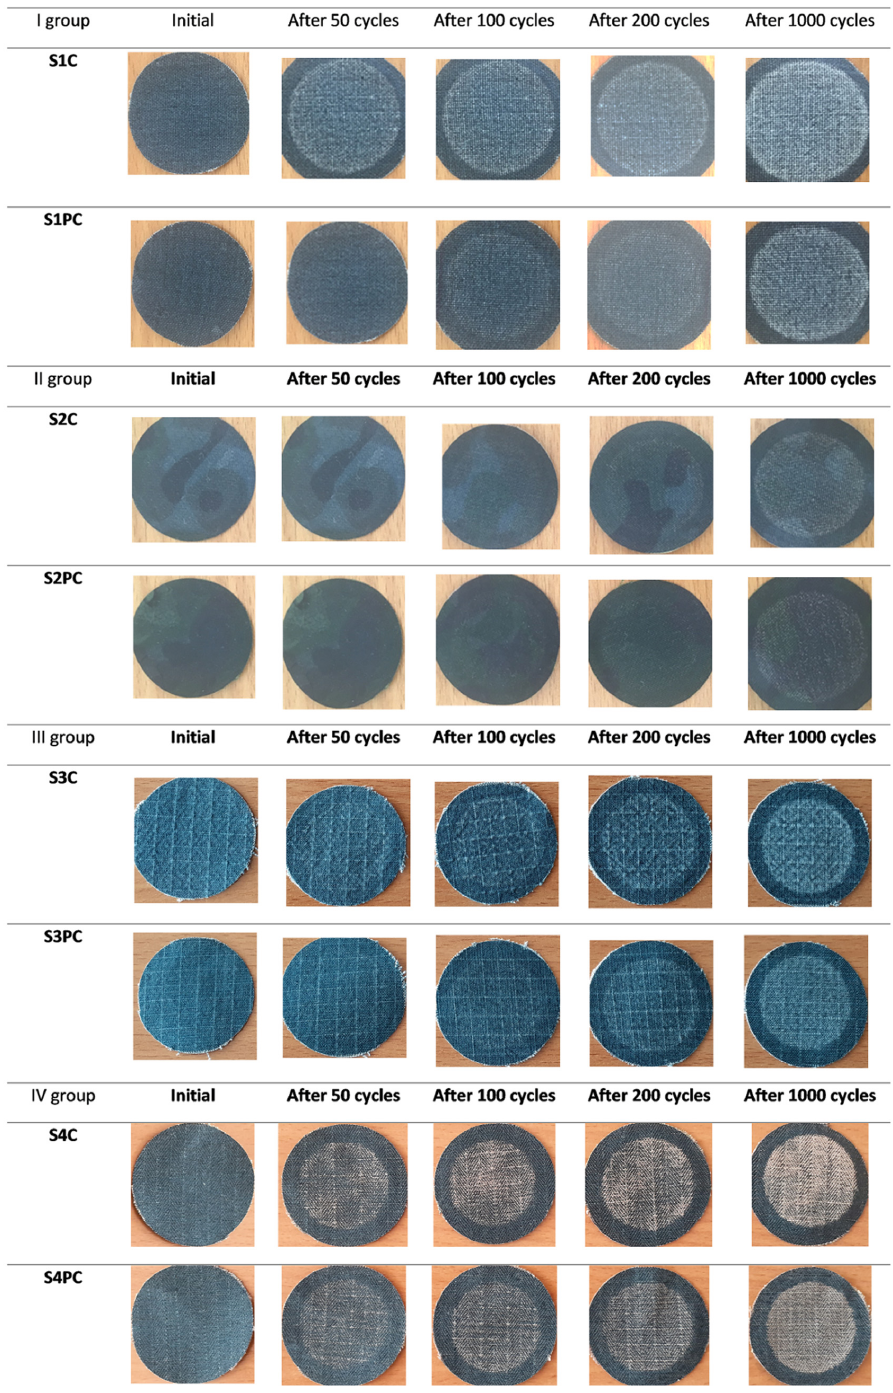
Figure 12. Coated fabric samples after being subjected to abrasion in the Martindale abrasion tester.